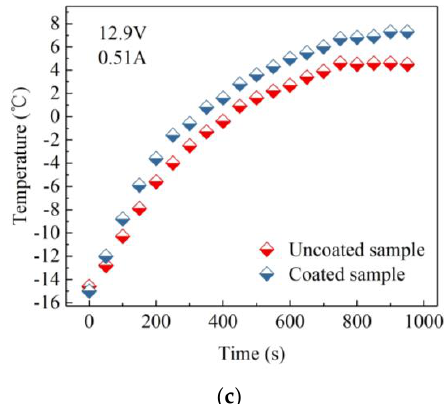
Figure 4. Temperature profile of the anti-/deicing component at different applied voltages. ( a ) Applied voltage: 10.9 V, 0.43 A; ( b ) applied voltage: 11.5 V, 0.46 A ; ( c ) applied voltage: 12.9 V, 0.51 A.